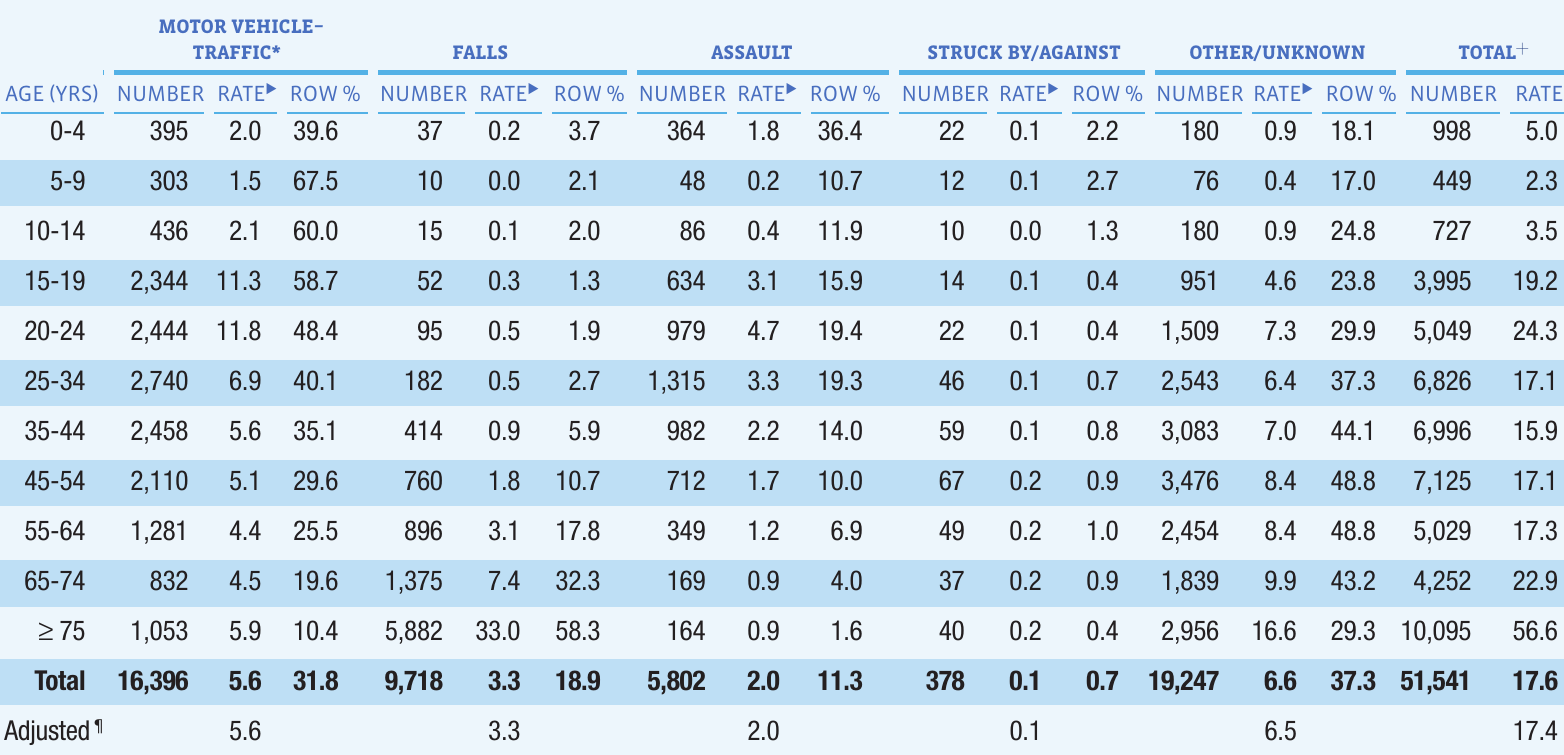
TABLE 16: Average Annual Numbers, Rates, and Percentages of Traumatic Brain Injury-Related Deaths, by Age Group and External Cause, United States,